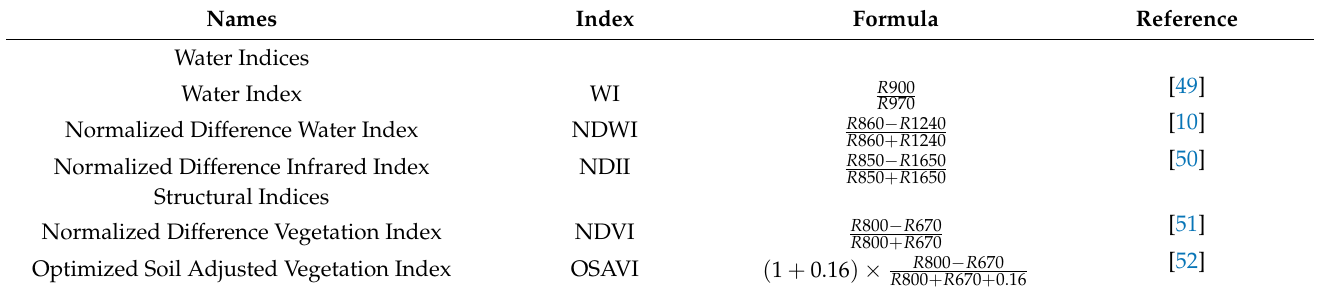
Table 1. Spectral vegetation indices used to estimate plant water stress in this